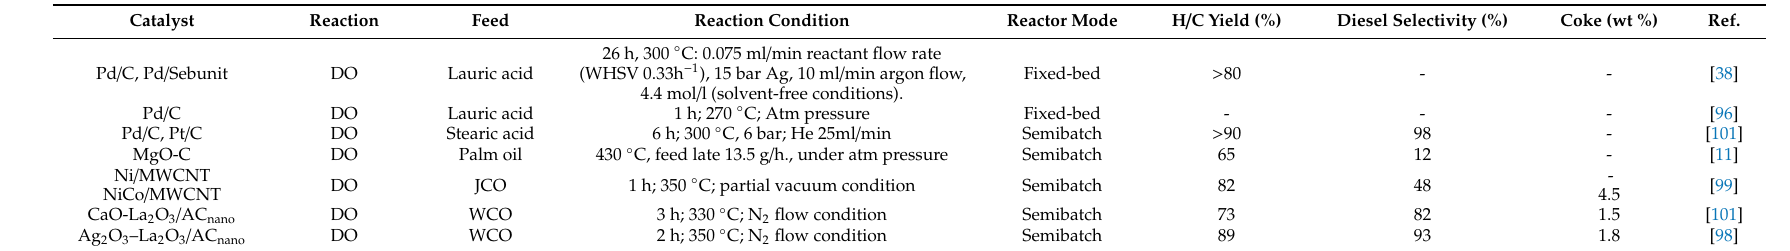
Table 3. Summary of the carbon-based catalysts in DO via the decarboxylation / decarbonylation